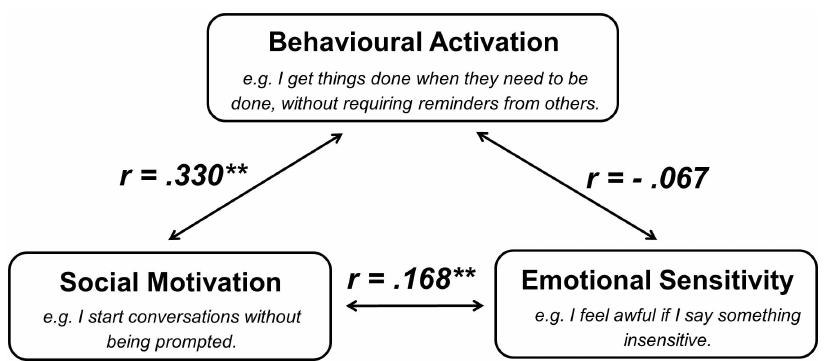
Fig 1. Apathy Motivation Index (AMI) factor model. The factor analysisidentifiedthree distinct subscales, namely behavioural activation(BA), social motivation(SM) and emotional sensitivity (ES). BA relates to an individual’s tendencyto self-initiate goal-directed behaviour,SM examinesa person’sengagementof social interactions and ES probes an individual’s feelingsof positive and negative affection. While SM correlated with BA and ES, BA did not associate with ES. ( ** : p < 0.01).